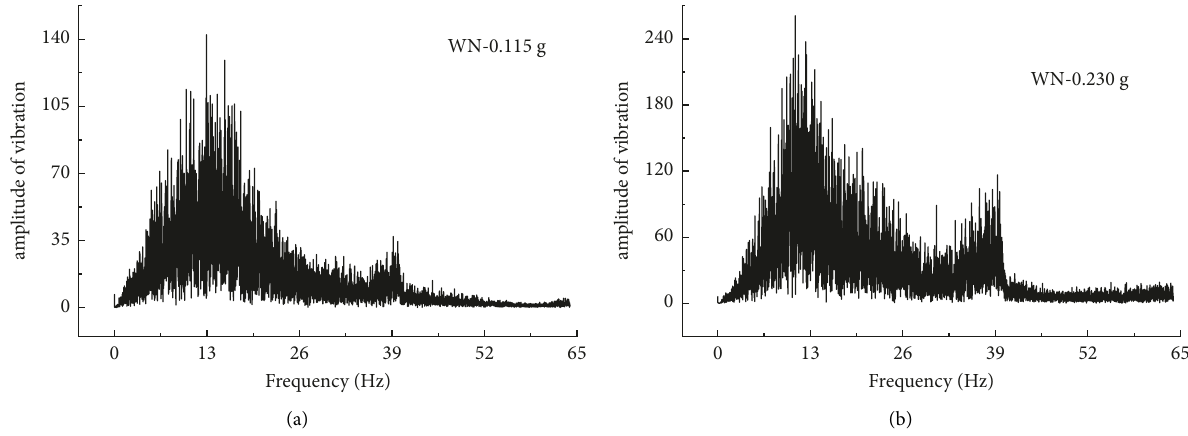
Figure 11: White noise spectrum curve of soil-rock combination field. (a) White noise − 0.115 g. (b) White noise − 0.230g.